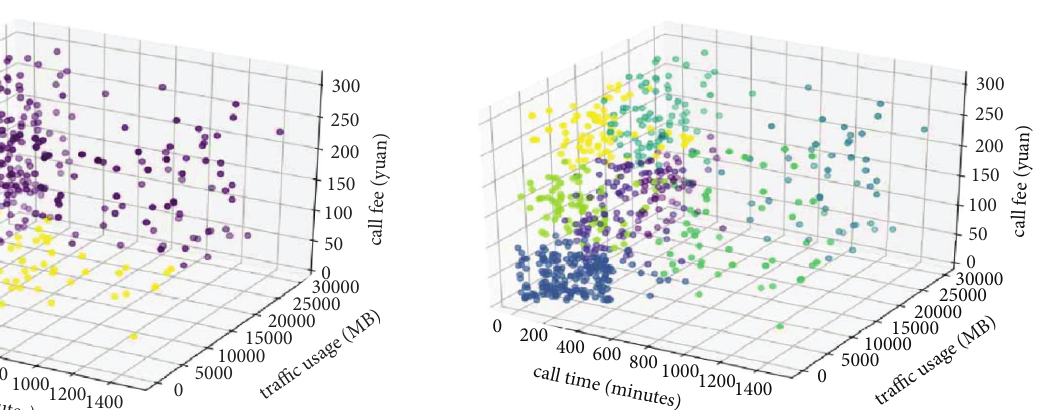
Figure 4: Clustering analysis of user traffic flow: ( k � 3).